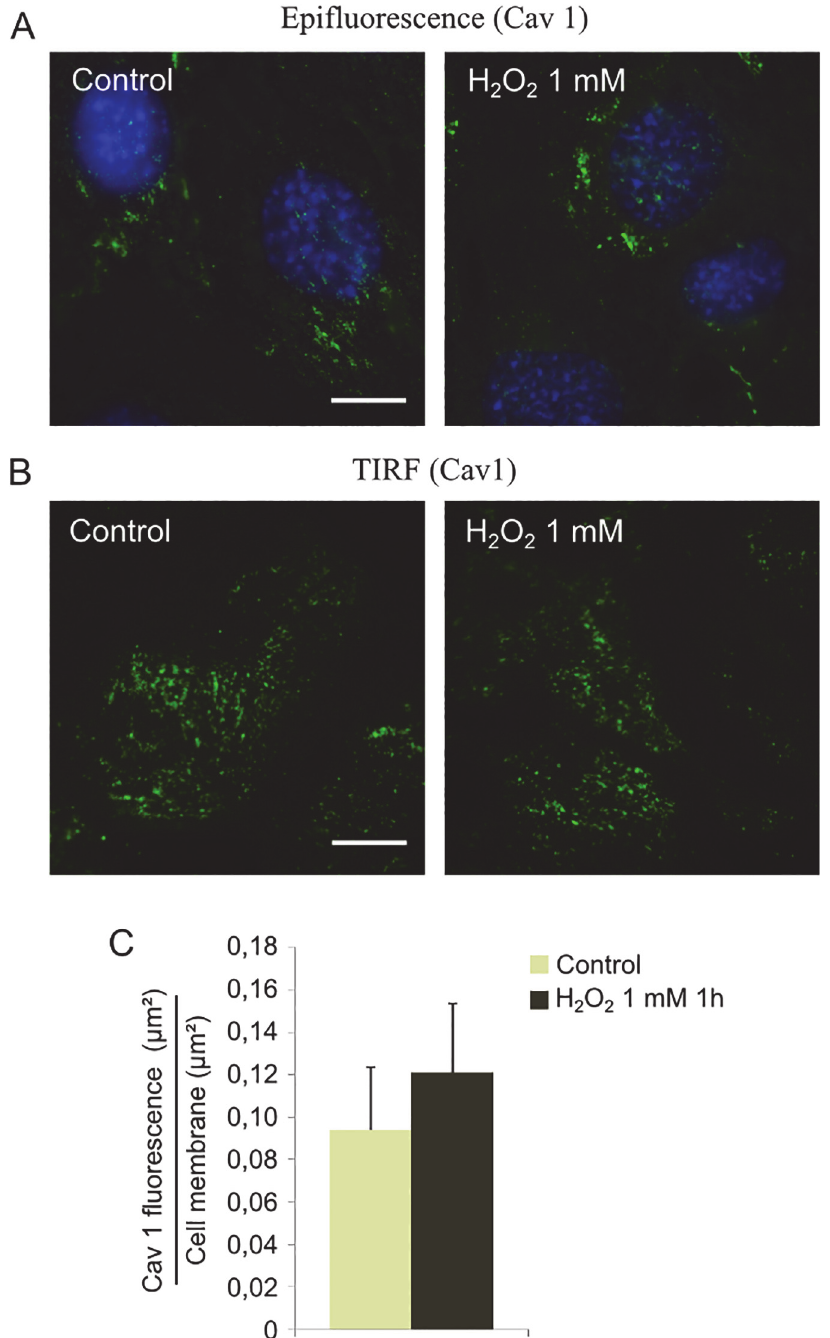
Fig 4. Effect of H 2 O 2 on caveolin 1 localization. Cells were treated with 1 mM H 2 O 2 during 1h. Caveolin 1 localization in C 2 C 12 cells was determined by immunofluorescence labelling (A) or TIRF imaging (B). The ratio between membrane area with caveolin 1 labeling and total membrane area was expressed after TIRF images analysis (C). Bars on the graph represent the SEM. Scale bar = 10 μ